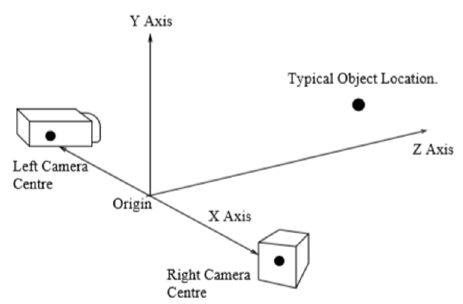
Figure 10. Eye tracking system based on two cameras.